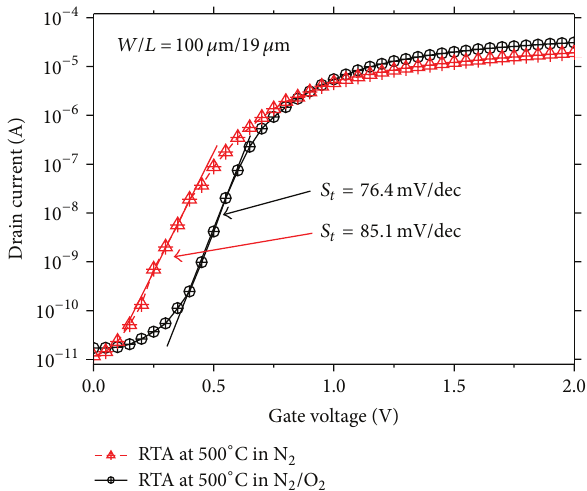
Figure 3: 𝐼 - 𝑉 characteristics of nMOSFETs fabricated with DS GS HfO 2 gate dielectrics annealed in N 2 and N 2 /O 2 at 500 ∘ C for